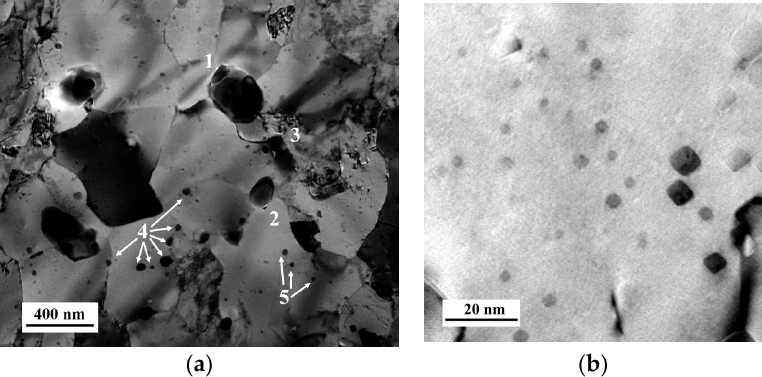
Figure 4. TEM micrographs showing precipitates observed from ODS steel after HE: ( a ) Type 1 precipitates (points 1–5) and ( b ) nanometric squared Type 2 precipitates. Type 1: Round or irregular-shaped particle not homogeneously distributed within the matrix.